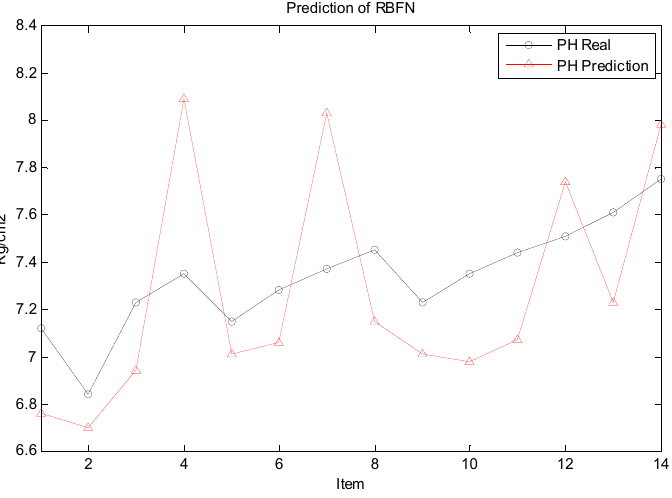
Figure 4. The prediction of a brine chiller’s efficacy.